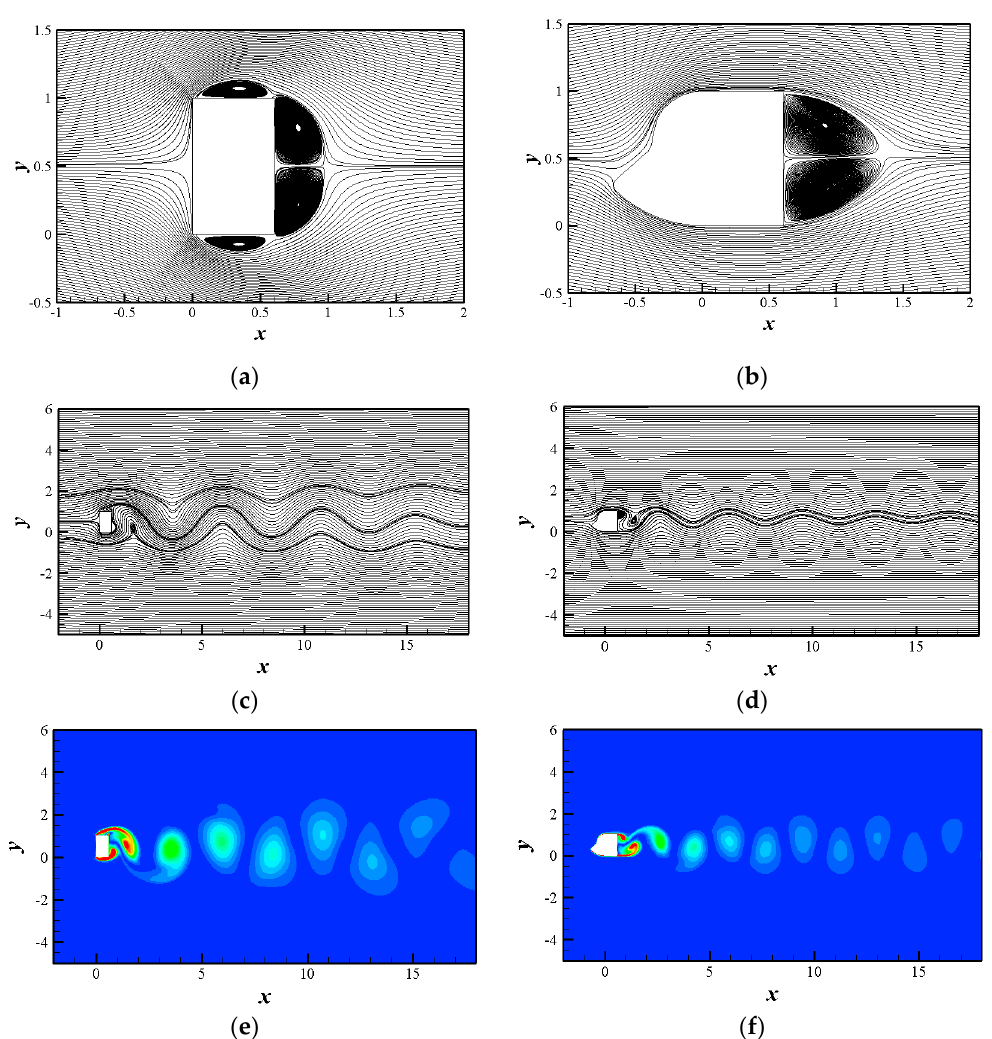
Figure 11. Flow visualization images: ( a , b ): time-average streamlines contours; ( c , d ): instantaneous streamlines contours and ( e , f ): vorticity contours. ( a ) Rectangular cylinder ( b ) bionic attachment cylinder; ( c ) rectangular cylinder; ( d ) bionic attachment cylinder; ( e ) rectangular cylinder and ( f ) bionic attachment cylinder.